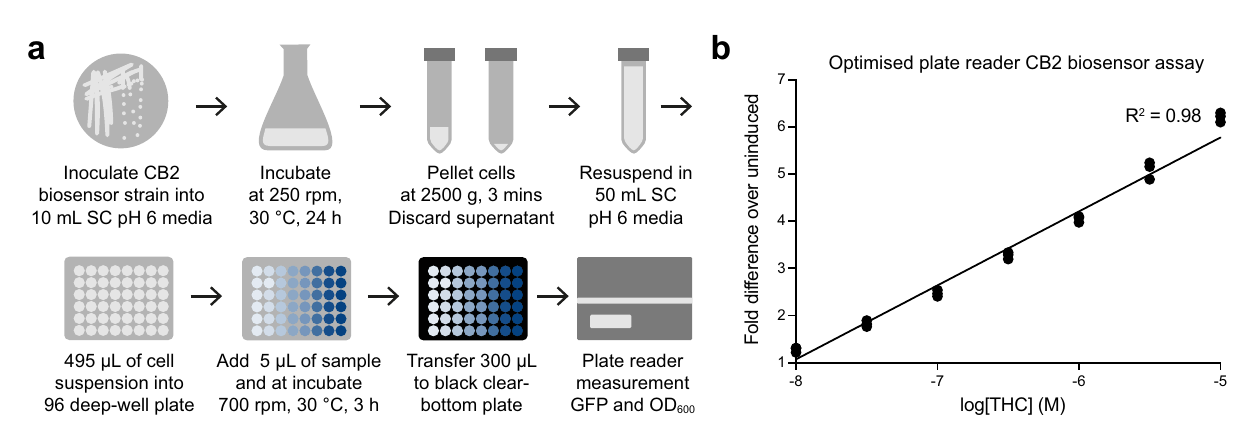
Fig. 3 | Optimised CB2 biosensor plate reader assay. a Optimised work fl ow for CB2 biosensor strain preparation, sample incubation, and plate reader measure- ment of 96 samples. Throughput can be linearly scaled with starting culture volume. b THC dose-response curve using the optimised CB2 biosensor plate reader assay over the linear range of GFP output (0.01 – 10 µ M of THC). Data was